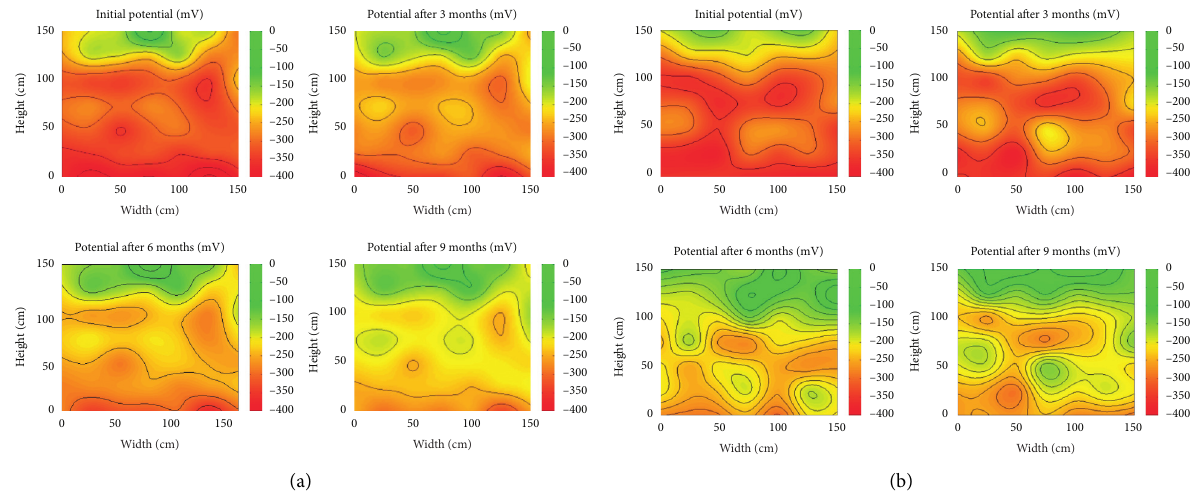
Figure 11: Potential of rebar in existing concrete. (a) Potential of brushing repair. (b) Potential of composite repair.